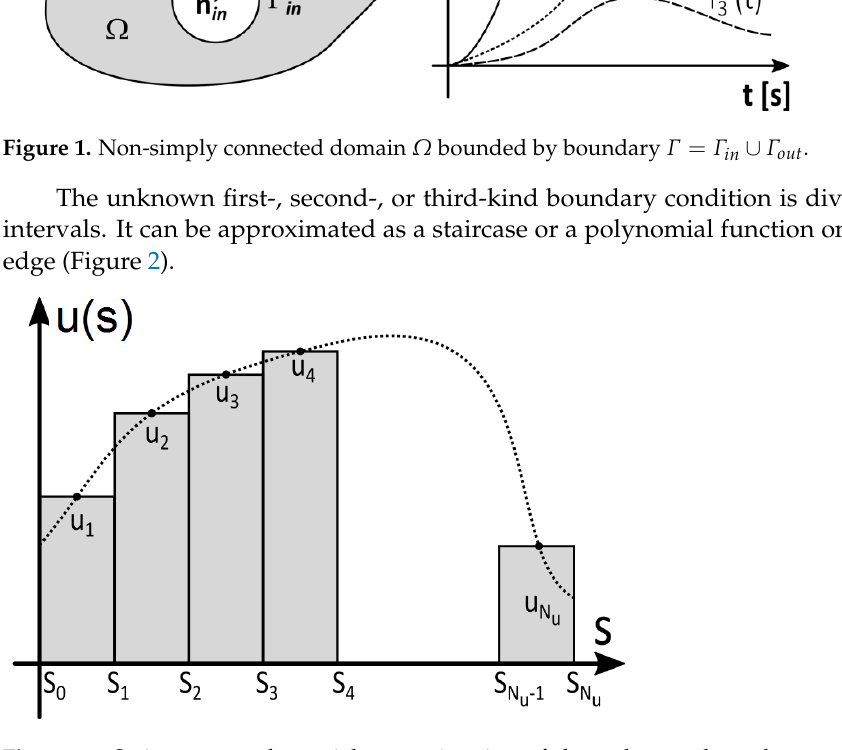
. Figure 3. Diagram illustrating the calculation of u L using future time steps. The least squares method is applied to estimate parameters u L . The sum of squares